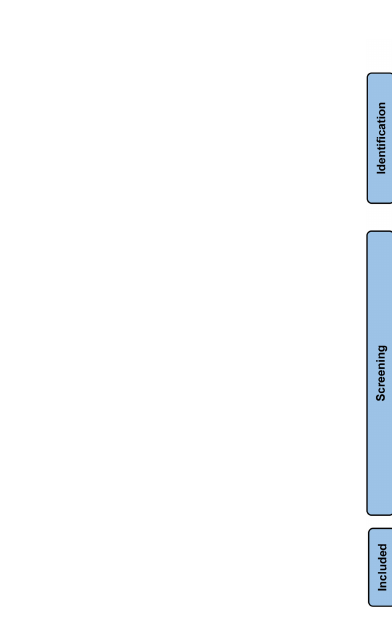
FIGURE 1 | Flow diagram of the study selection